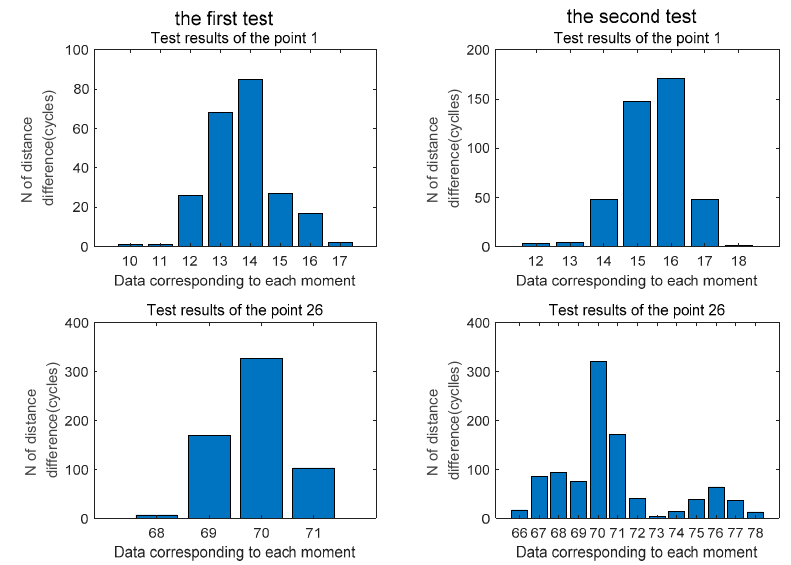
Figure 16. The probability statistical distribution map of 21, 23, and 30 points.